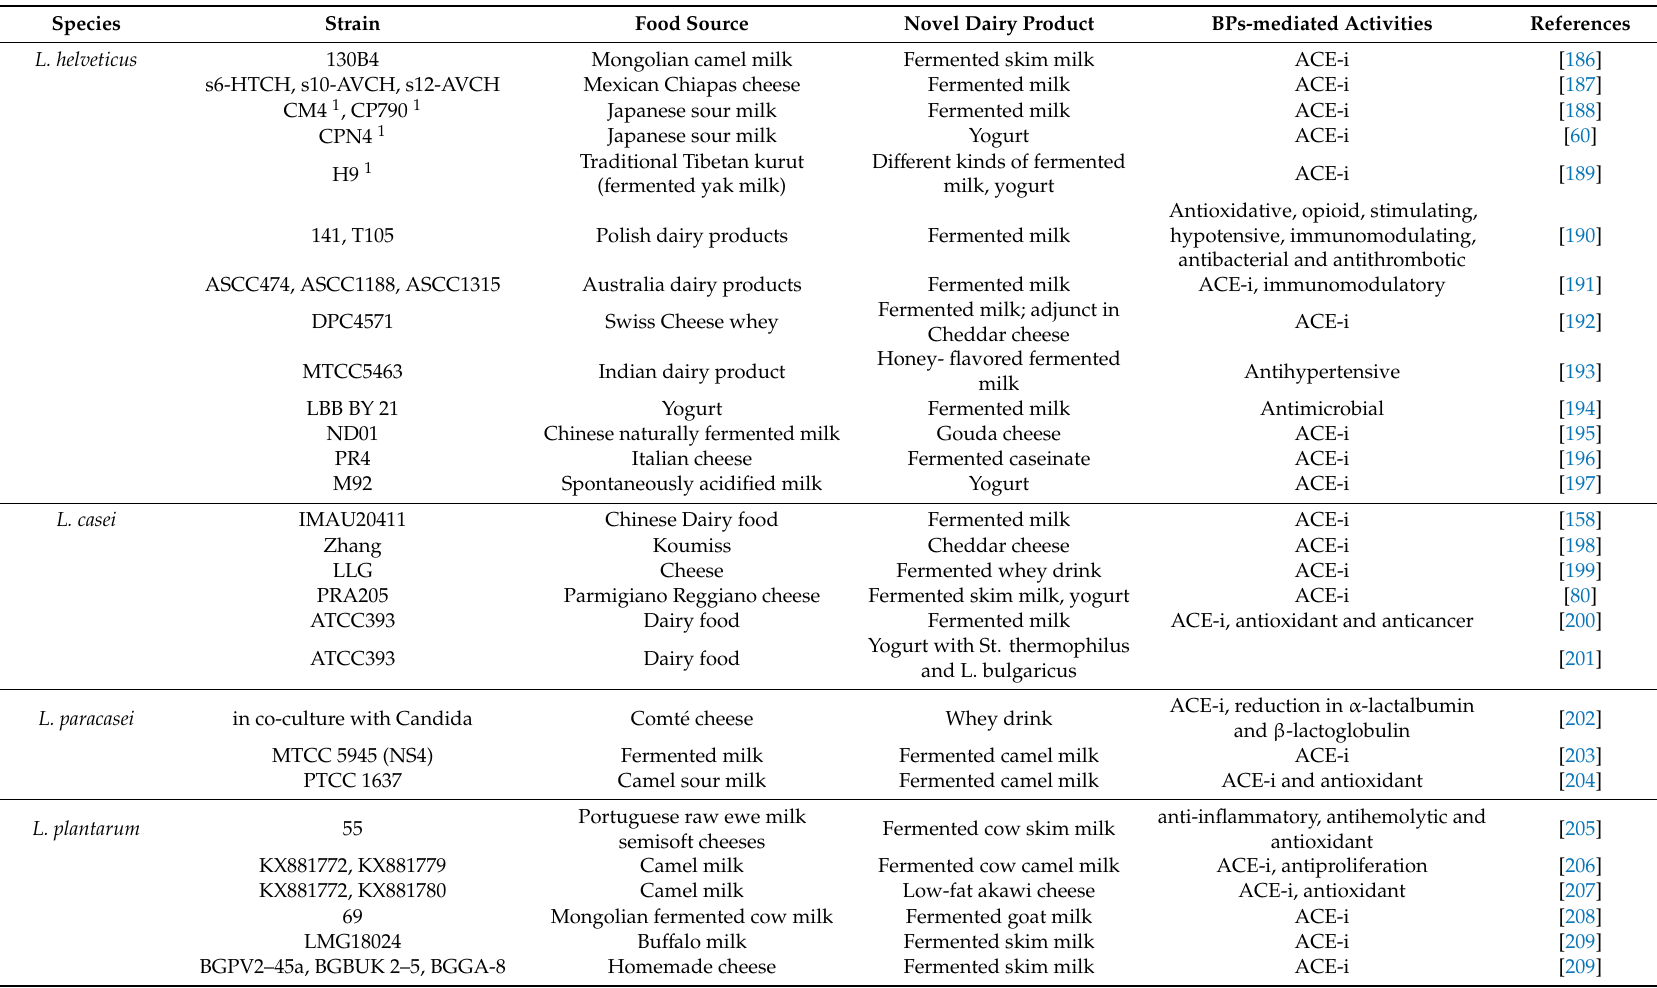
Table 5. Main lactic acid bacteria (LAB) strains isolated from FDFs and exploited in developing novel dairy food enriched in BPs.